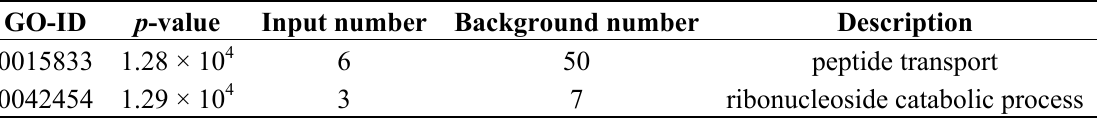
Table 6. Over-represented GO terms of TF-specific